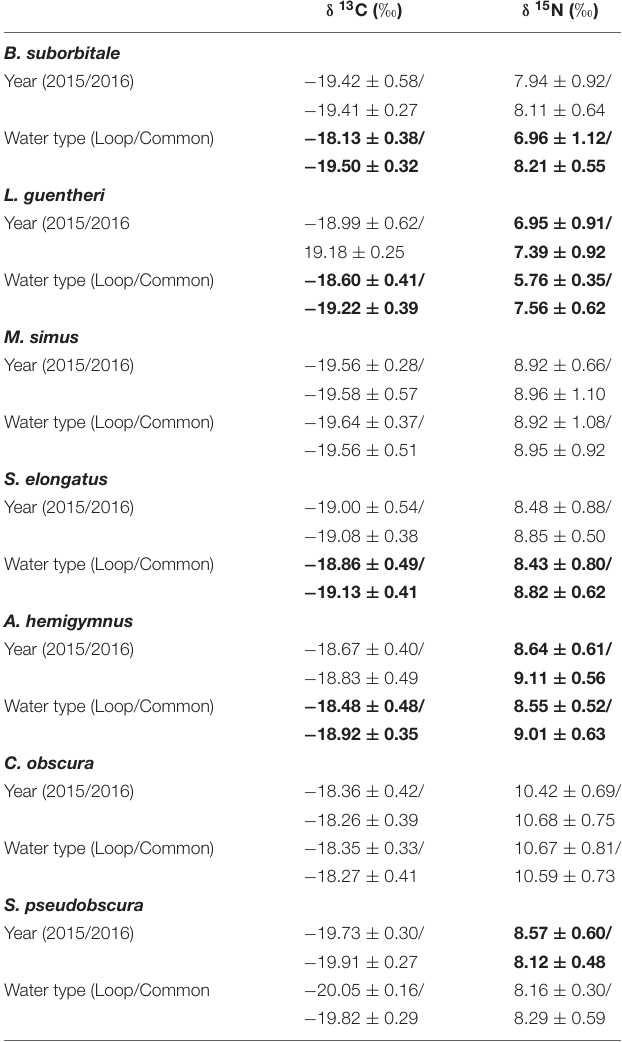
TABLE 4 | Mean ( ± SD) δ 13 C and δ 15 N stable isotope ratios of deep-pelagic fishes between sampling years (2015/2016) and water types (Loop Current/Common